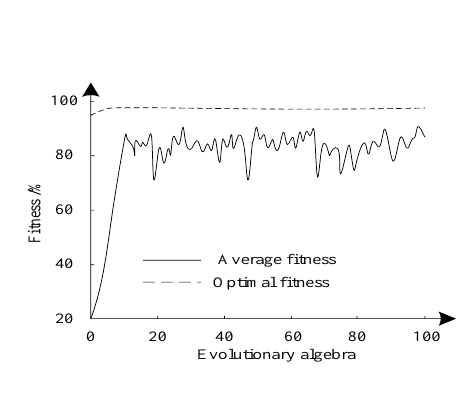
Fig 4. Optimization results of support vector machine parameters by genetic algorithm